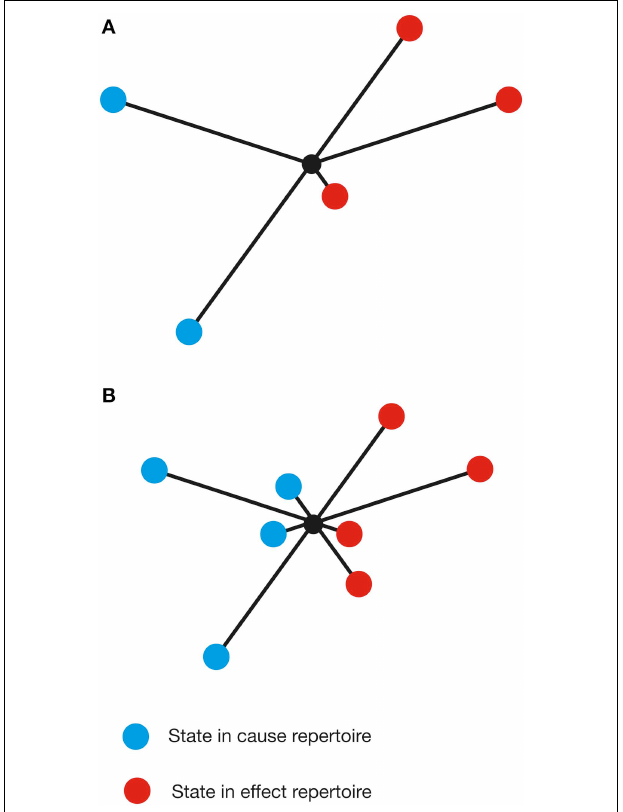
FIGURE 6 | A concept can be visualized by plotting the states of the cause-effect repertoire on a set of arbitrary axes, with the length of each line representing the probability of each state ( ϕ not considered). (A) A concept in a normal waking state. (B) A higher-dimensional psychedelic state concept, derived using the linear combination method described in the